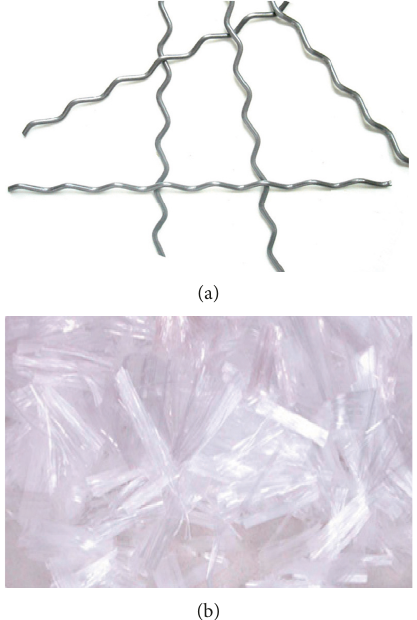
Figure 2: Respective features of (a) SF and (b)